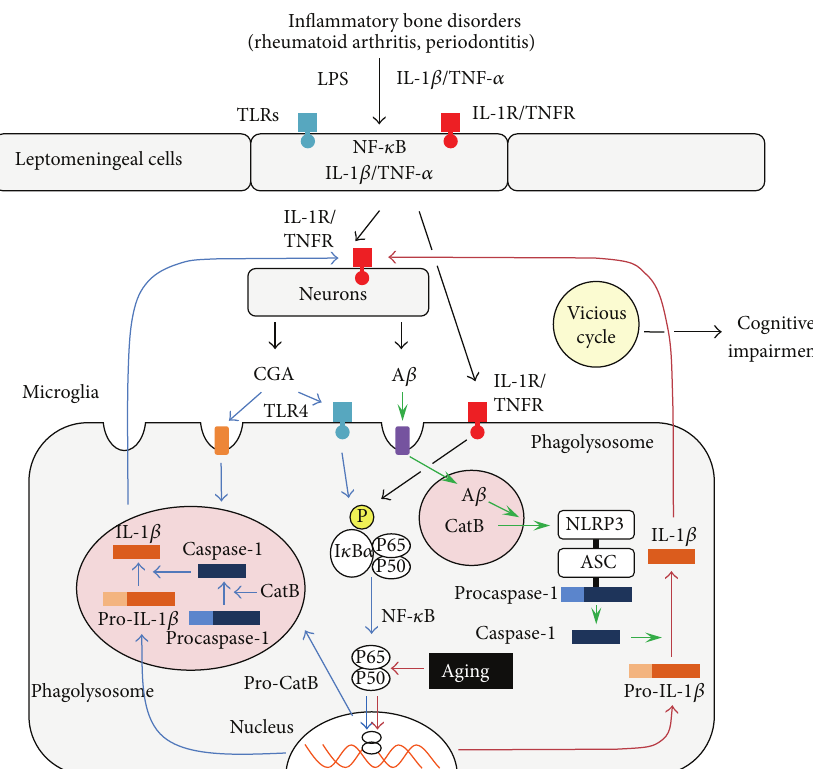
Figure 1: A schematic illustration of the transduction of signals from inflammatory bone diseases to brain-resident microglia through the leptomeninges and two different pathways for the IL-1 𝛽 production activated by CGA and A 𝛽 in microglia. In individuals with inflammatory bone diseases, IL-1 𝛽 and TNF- 𝛼 secreted by macrophages and periodontal bacterial components, including LPS, activate IL-1R/TNFR and TLRs localized on the surface of leptomeningeal cells to secrete IL-1 𝛽 and TNF- 𝛼 . IL-1 𝛽 and TNF- 𝛼 then stimulate both brain-resident microglia and neurons. After stimulation, the neuronal production and secretion of CGA and A 𝛽 is increased. CGA and A 𝛽 subsequently activate two different pathways for the IL-1 𝛽 production in microglia, the NLRP3 inflammasome-CatB pathway via A 𝛽 (open arrows), and the phagosome-CatB pathway via CGA (blue arrows). The NF- 𝜅 B pathway activated during aging (red arrows) supports the production and secretion of IL-1 𝛽 by A 𝛽 . The leptomeningeal cell-neuron-microglia interactions form a vicious cycle of IL-1 𝛽 production, culminating in the onset of cognitive impairment in